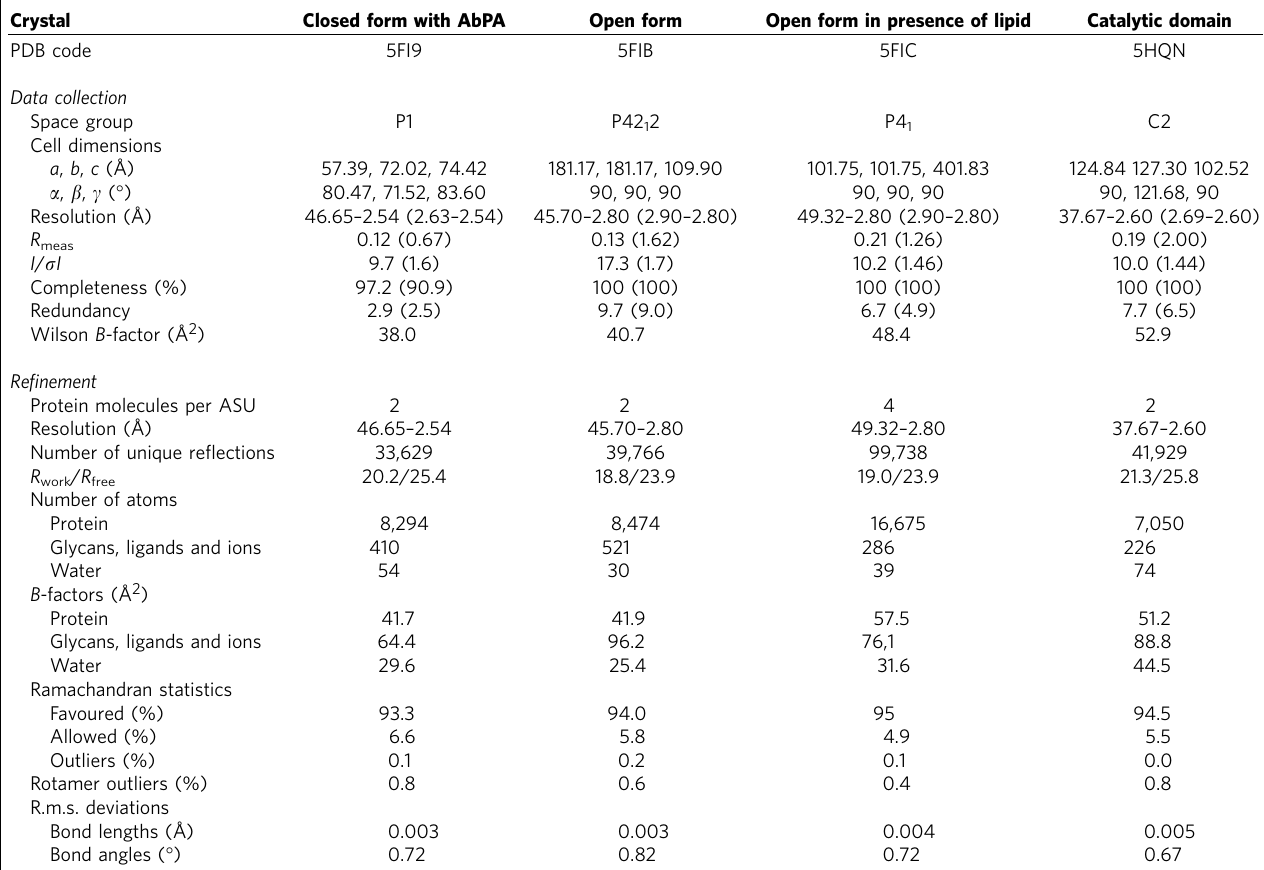
Table 1 | X-ray data collection and refinement